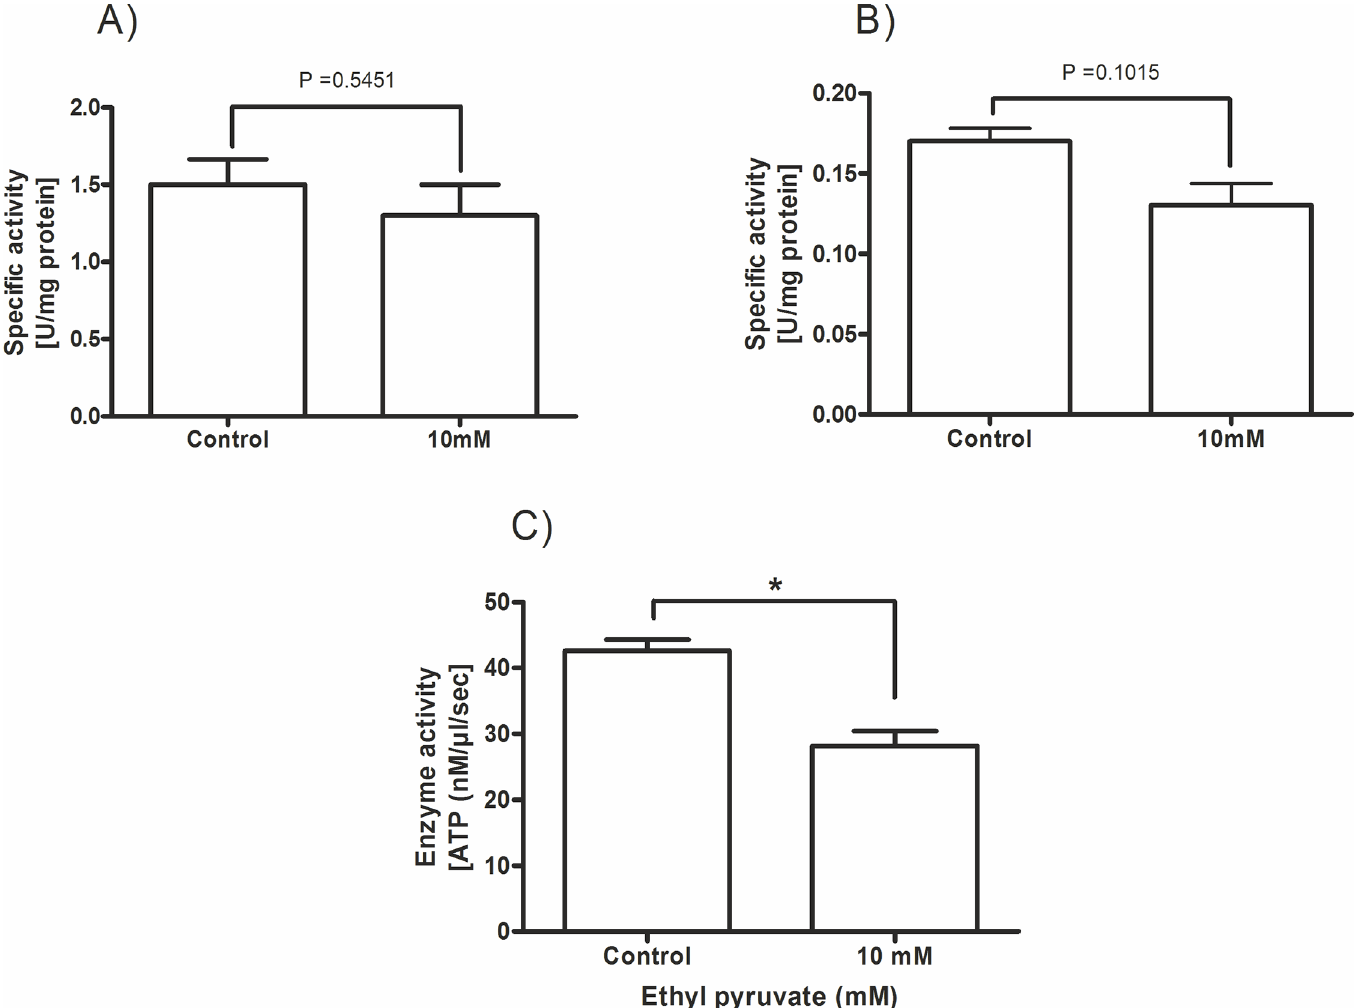
Fig 5. Effect of ethyl pyruvate on the activity of glycolytic enyzmes of T . brucei . Specific activity of glycolytic enzymes in T . brucei cell extracts in the absence and presence of 10 mM ethyl pyruvate. (A) hexokinase, (B) phosphofructokinase and (C) pyruvate kinase. All cell extracts were pre-treated with ethyl pyruvate for 30 min before activity testing. All experiments were performed in triplicates (n = 3), * p < 0.05.